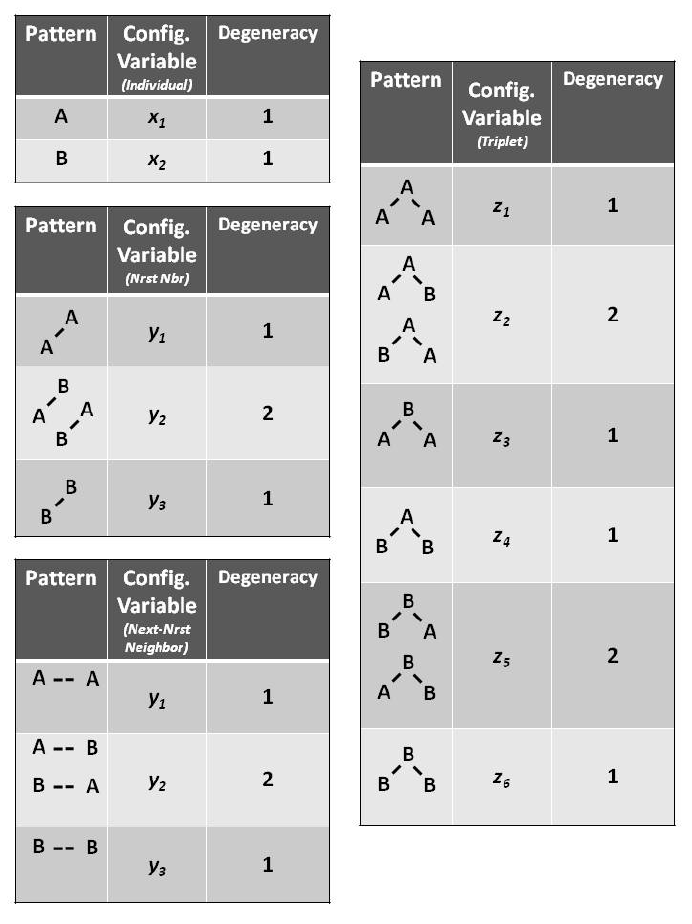
Figure 4. The ways in which the configurations variables y i , w i , and z i can be constructed, together with their degeneracy factors β i and γ i